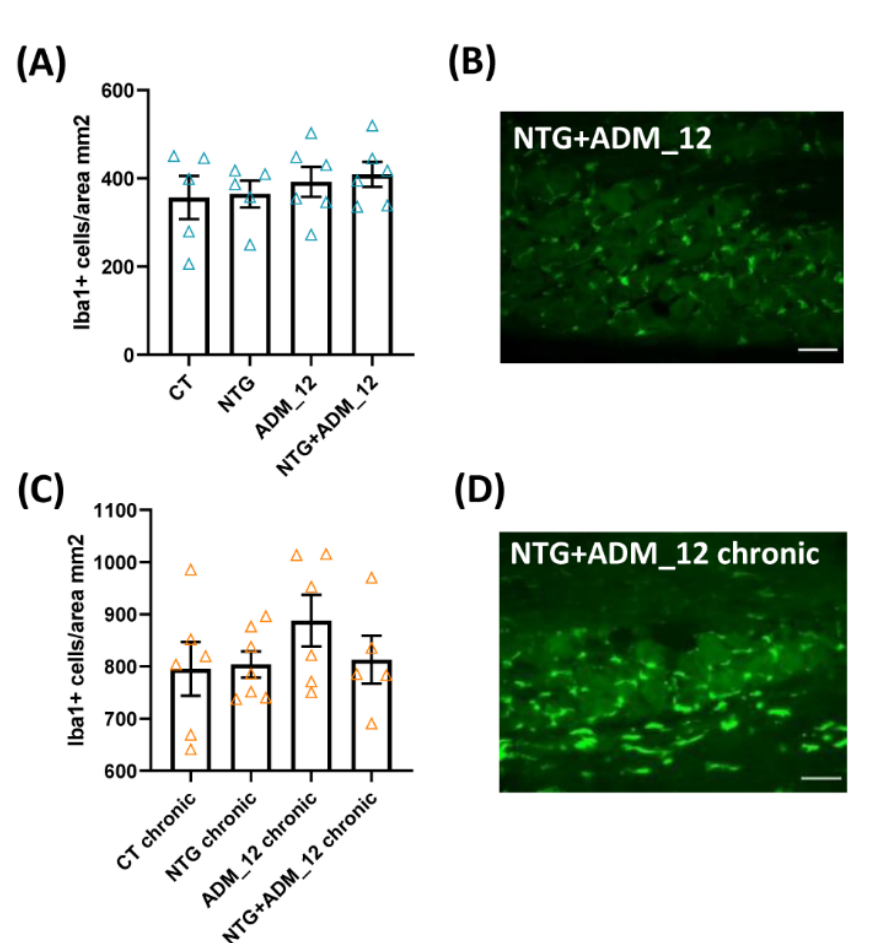
Figure 5. Effects of ADM_12 (30 mg/kg) on macrophage cell infiltration in the TG ipsilateral to formalin injection. Acute migraine model: ( A ) number of infiltrating macrophages (expressed as ionized calcium binding adaptor molecule 1 (Iba1)-positive cells per area in mm 2 ) ( n = 5–6 per group) and representative photomicrographs of the NTG + ADM_12 group ( B ); Green: Iba1. Scale bars: 50 µ m. Chronic migraine model: ( C ) Number of infiltrating macrophages (expressed as Iba1-positive cells per area in mm 2 ) ( n = 5–7 per group) and representative photomicrograph of the NTG + ADM_12 group ( D ); Green: Iba1. Scale bars: 50 µm. CT: Control. Data are expressed as mean ± SEM. One way ANOVA followed by Tukey’s multiple comparisons test.